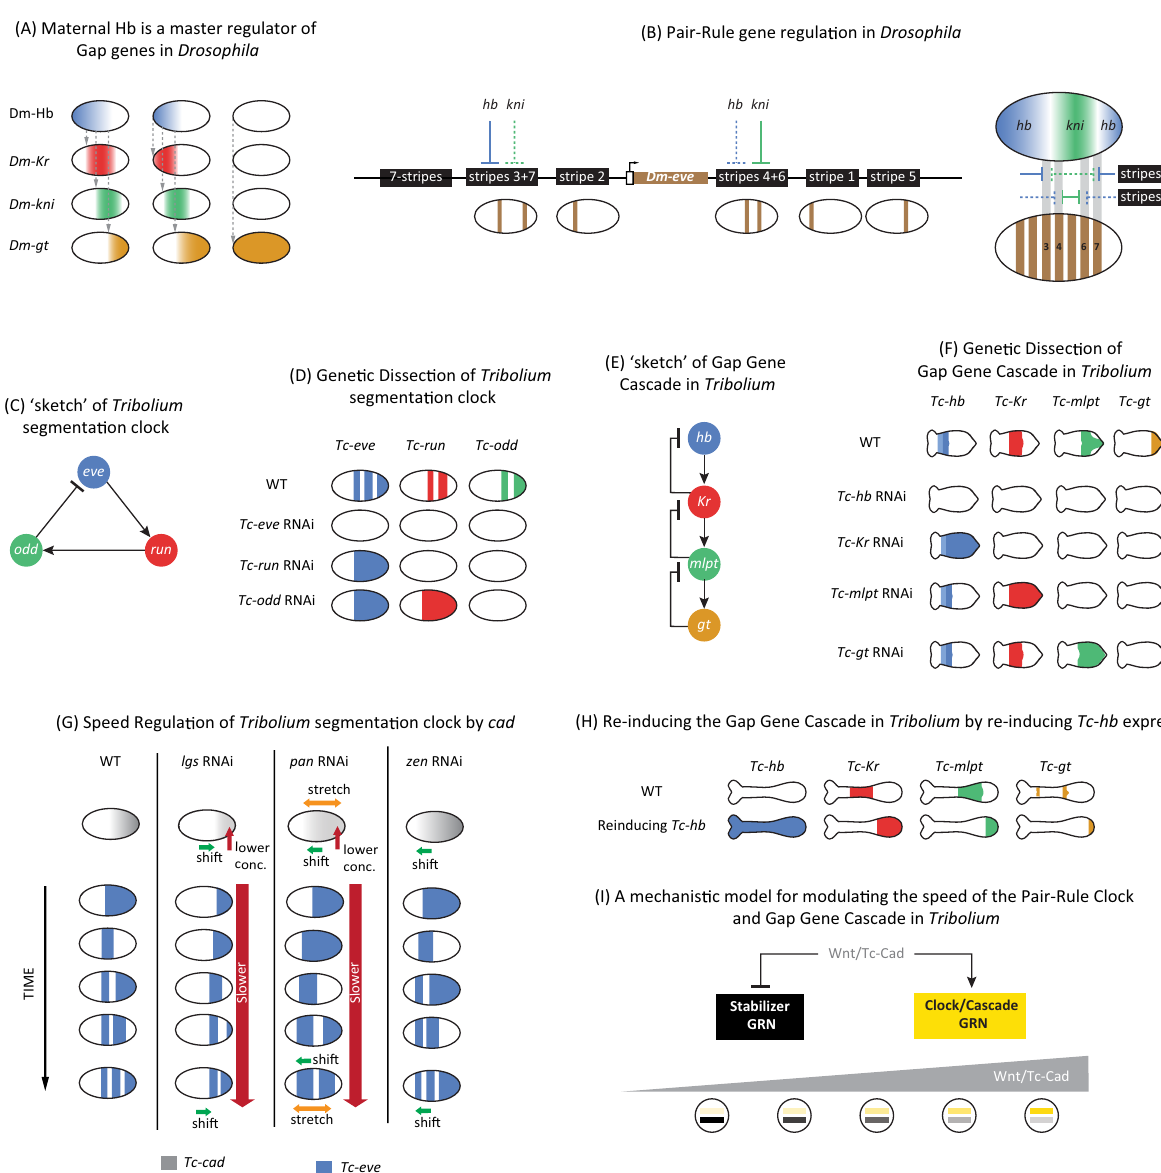
Fig 4. Segmentation and regionalization mechanisms in insects. (A) Maternal Dm-Hb gradient acts as a master regulator of gap genes in Drosophila . Progressive reduction of maternal Dm-Hb gradient (in various mutant backgrounds) results in progressive shifts of gap gene domains toward anterior. (B) Pair-rule stripes (shown for Dm-eve ) are specified in a stripe-specific fashion in Drosophila . Left: Each one or pair of Dm-eve stripes are specified by a specific enhancer that receives inputs from upstream gap genes (shown repressive gap inputs for the 3+7 and 4+6 enhancers; strong repression shown in sold lines; weak repression in dashed lines). The full 7-stripe pattern is then stabilized by a 7-stripe (or zebra) enhancer. Right: Shown how the regulatory logics of 3+7 and 4+6 Dm-eve enhancers translates upstream gap gene expressions (shown are those of Dm-Kr and Dm-kni ) into stripe